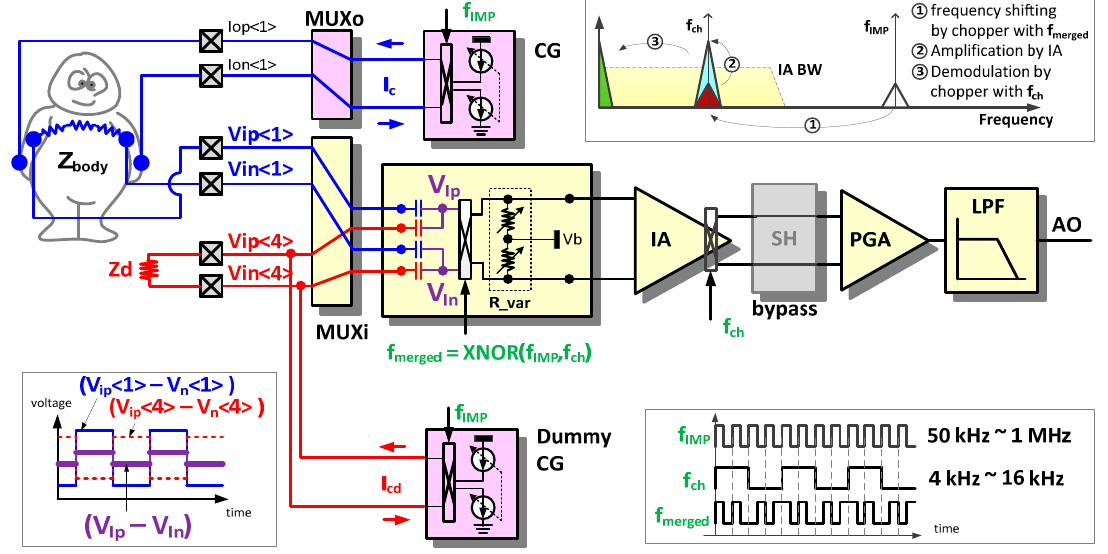
Figure 6. Reconfiguration of the readout channel for impedance (IMP) sensing mode.